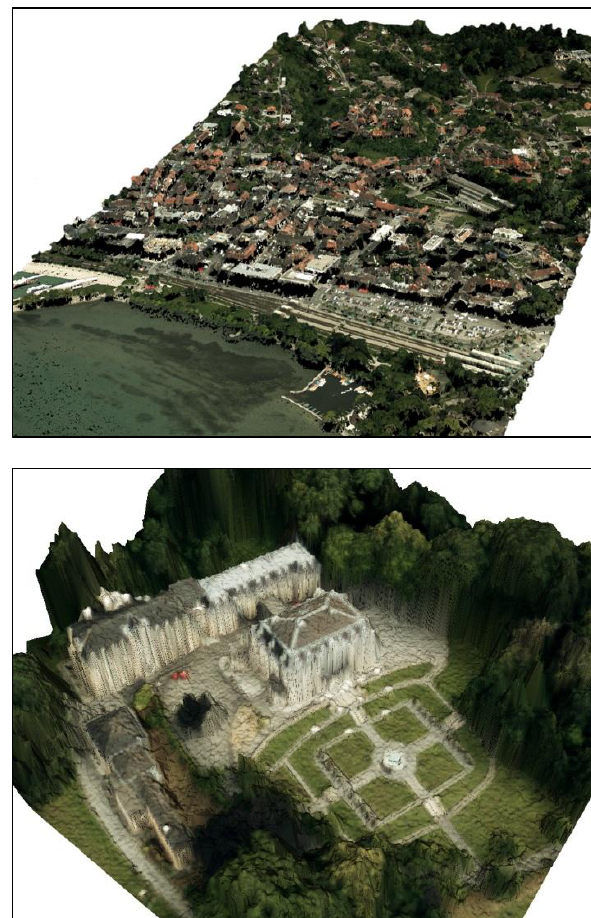
Figure 5: RGB colored info cloud of an ADS80 job in Down- town Sacramento (top) and enlarged TIN view of the California State Capitol (bottom).